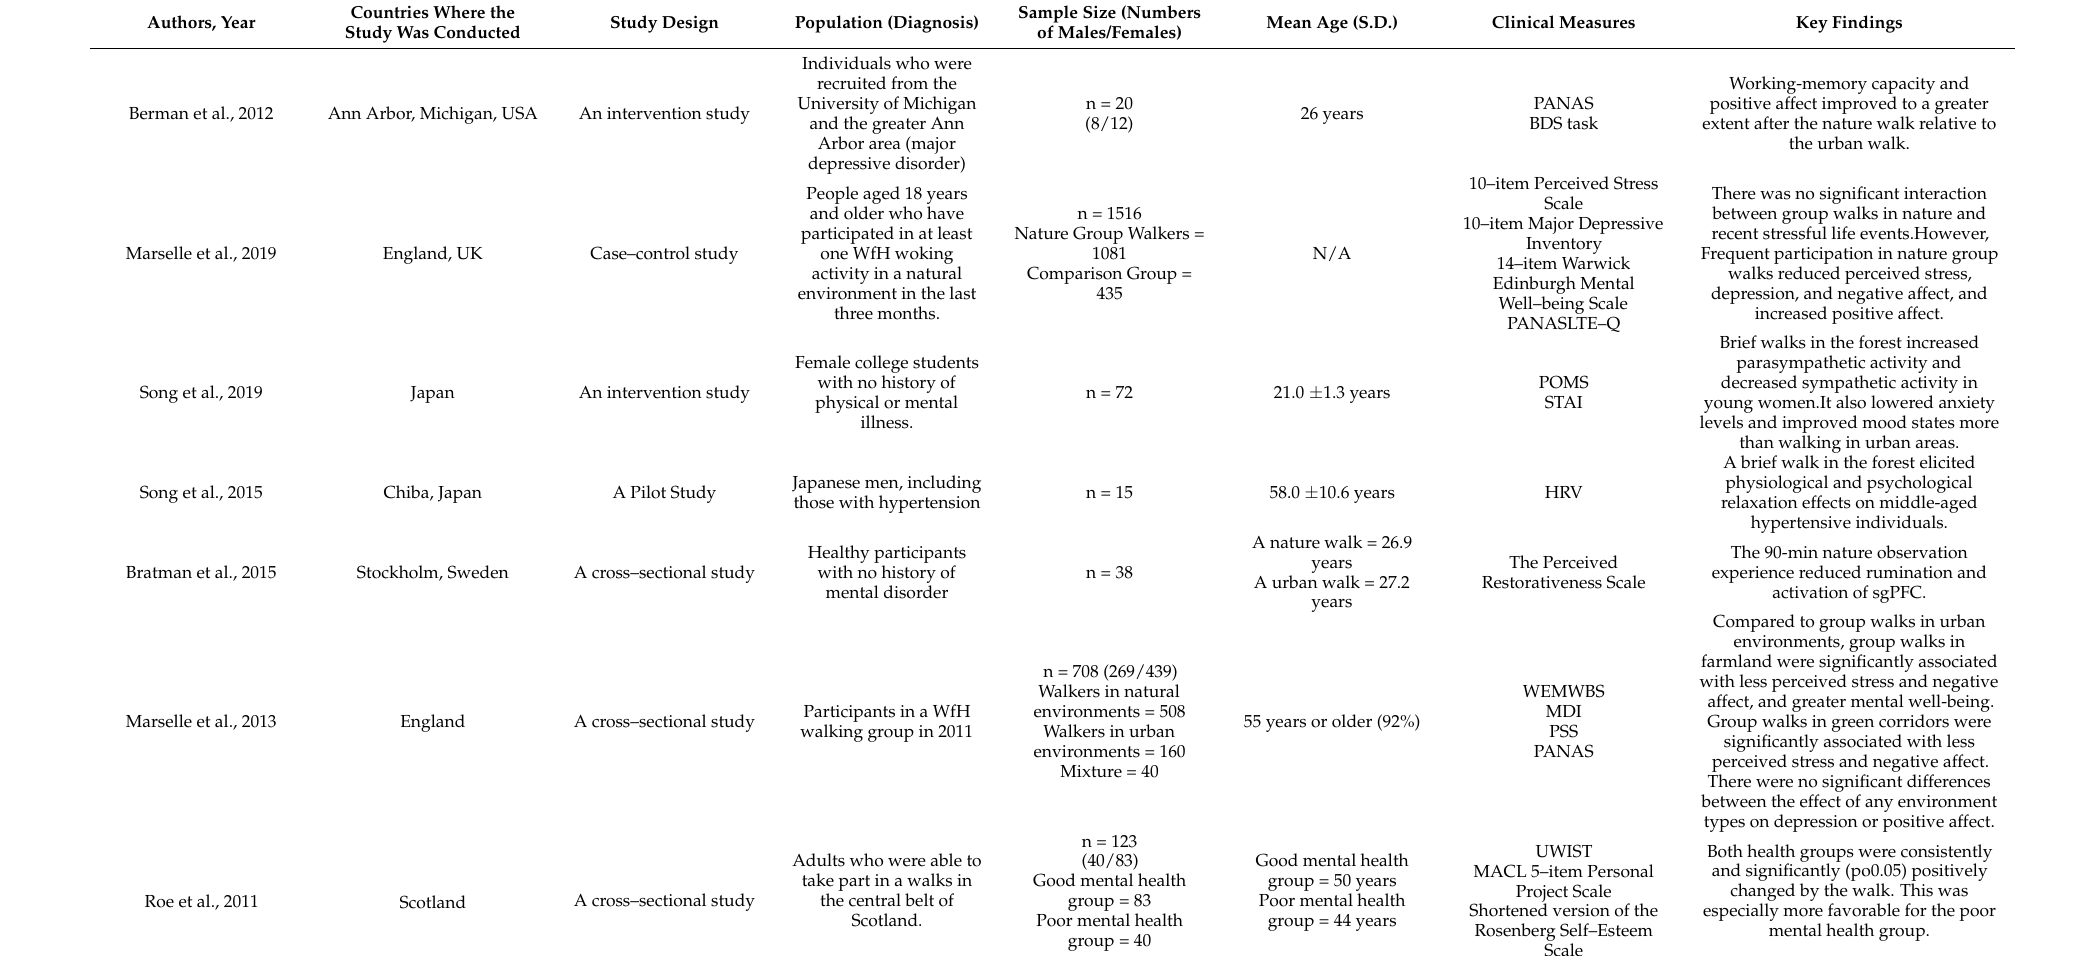
Table 3. Mixture of internal and external